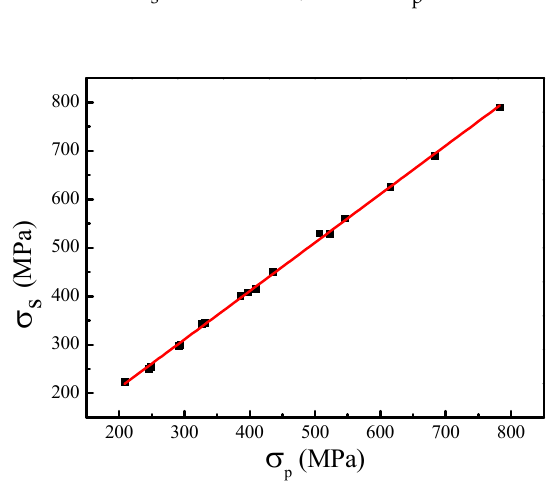
Figure 12. The relationship between σ s and σ p .